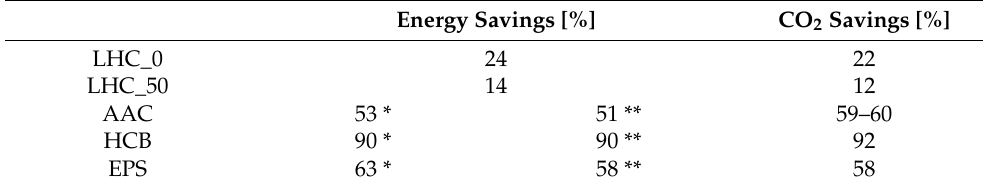
Table 5. The energy and CO 2 savings which can be obtained throughout the buildings’ life cycle if the building is made of LHC_100 instead of other materials (e.g., LHC_0/LHC_100). * is based on [33], and [33], and ** is based [42]. ** is based